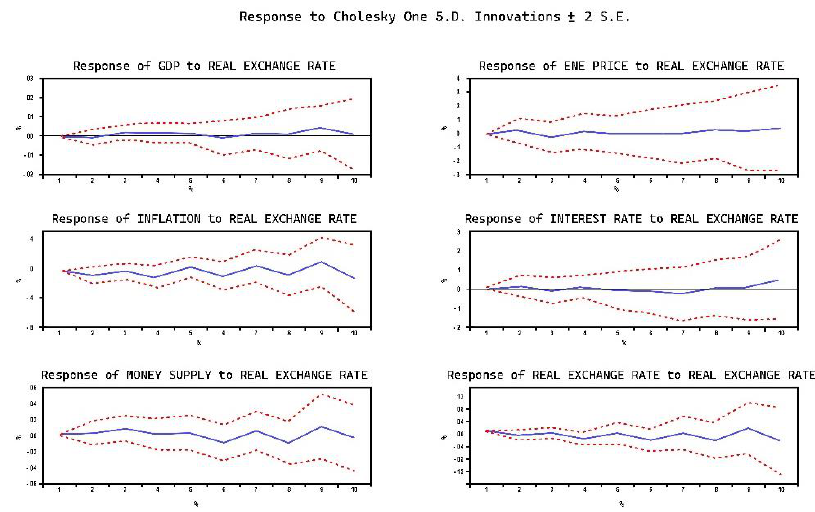
Figure 6. IRF to RER (VAR IRF with intercept using annual data for 1980 – 2022).